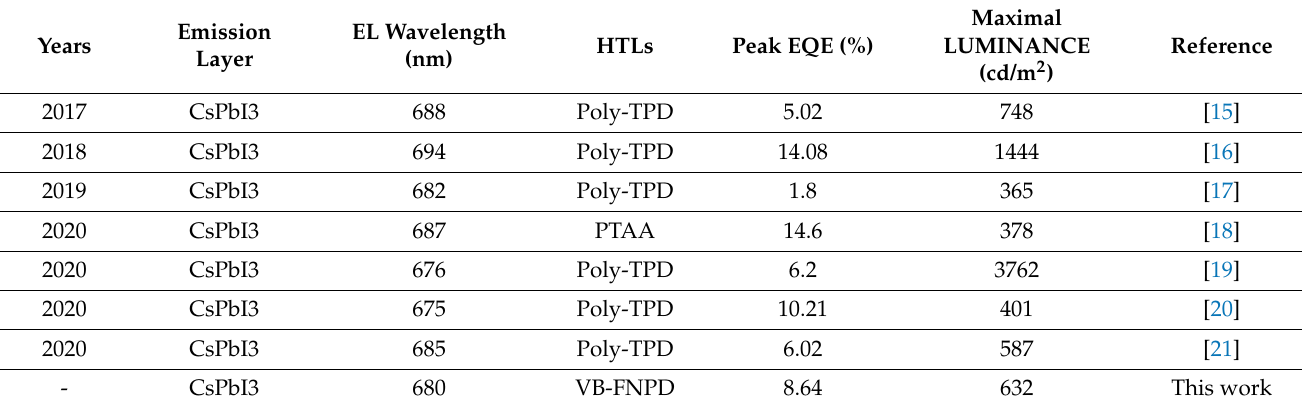
Table 1. Summary of recent reports of CsPbI 3 -based all-inorganic perovskite quantum-dot light-emitting diodes (IPQLEDs).